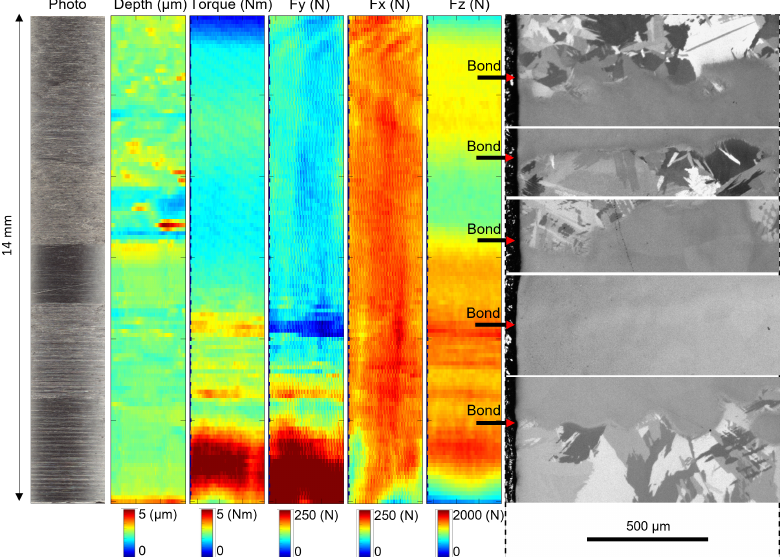
Figure 7. A photograph of the drilled surface, micrographs of the bond interfaces and depth, torque, Fy, Fx and FZ maps for holes drilled at 1845 RPM and F rev = 0.131 mm/rev in the Ti-3-2.5-Ti-5553-Ti- CP-Ti-6242-Beta C-Ti-64 workpiece (n blind